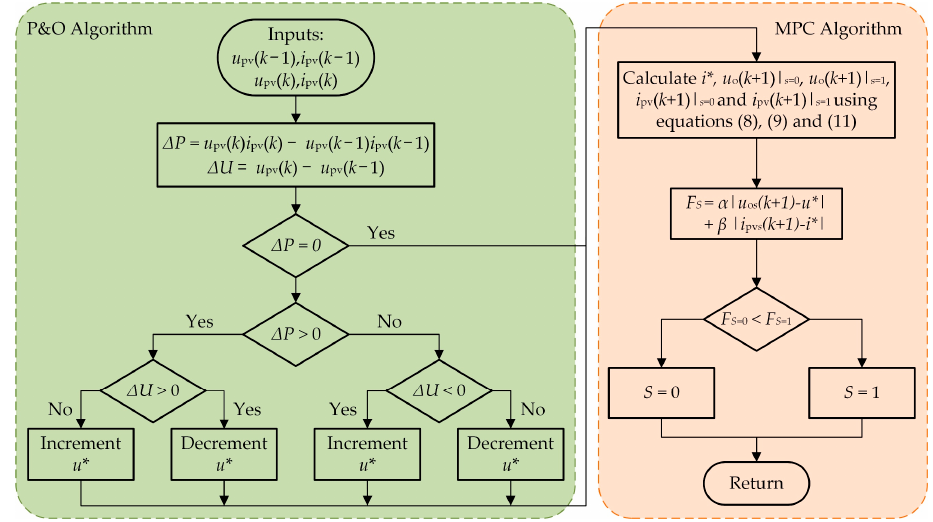
Figure 6. MPC-based MPPT algorithm for PV boost converter.